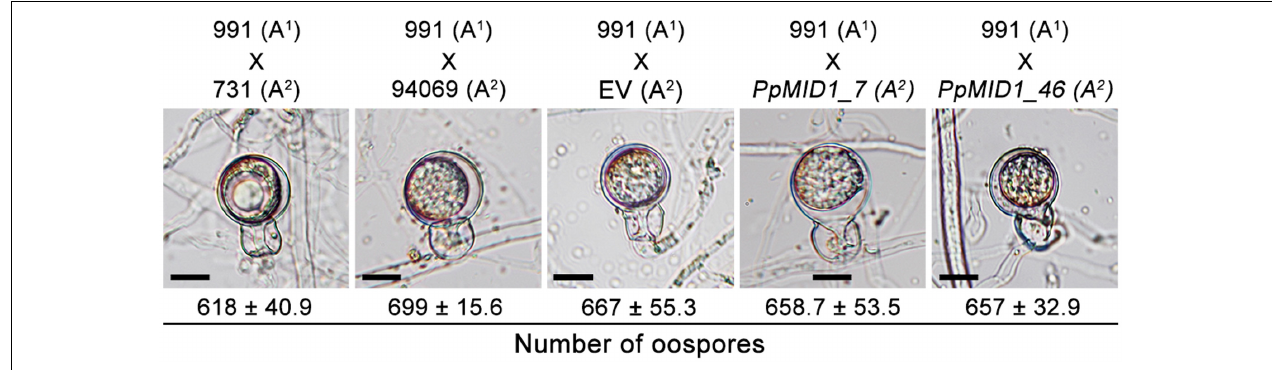
FIGURE 8 | Silencing of PpMID1 has no effect on oospore formation. Pairwise testing of PpMID1_7 , PpMID1_46 , EV, and wild-type strains of Phytophthora parasitica (94069, 991, and 731) for their ability to mate and produce oospores. Each paired agar culture was incubated at 25 ◦ C in the dark for 7 days, then examined under a microscope for oospore formation. Numbers under each photograph indicate the mean ± SD number of oospores present in 5 × 5 mm 2 agar blocks from 3 independent experiments ( n = 3). Bar = 12.5 µ